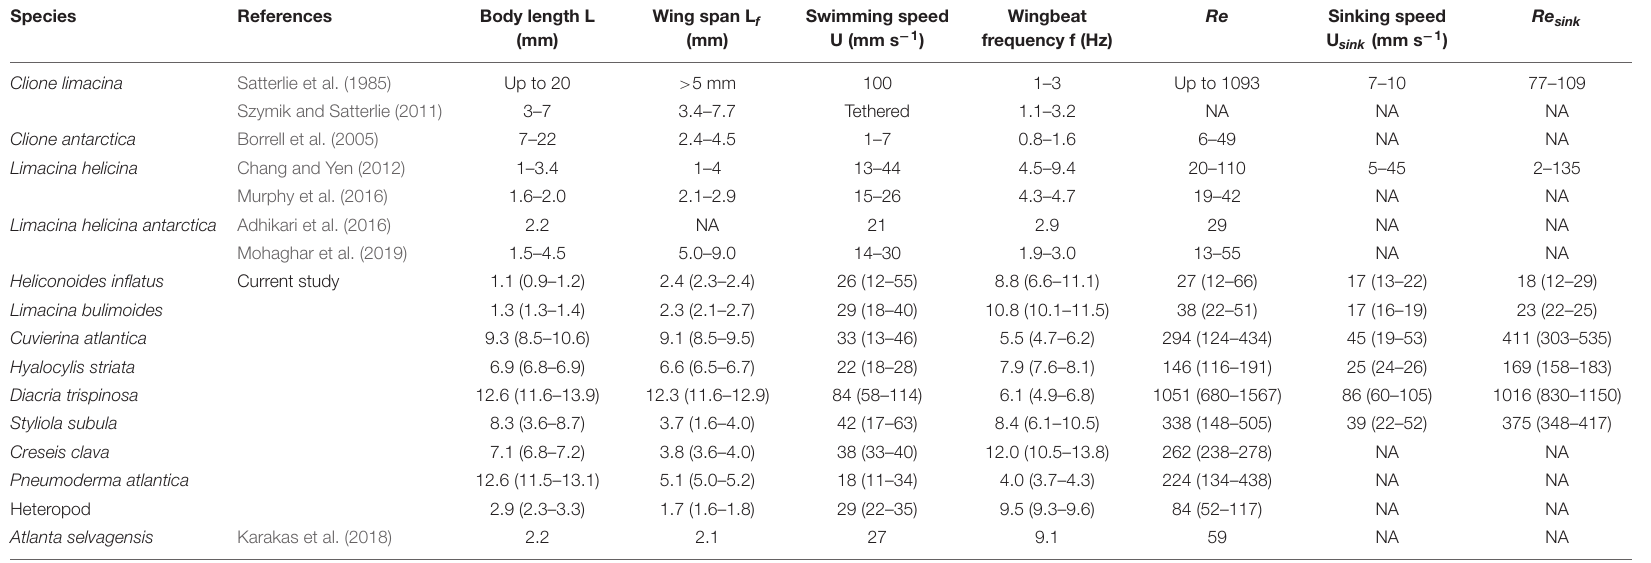
Values indicate mean and range (in